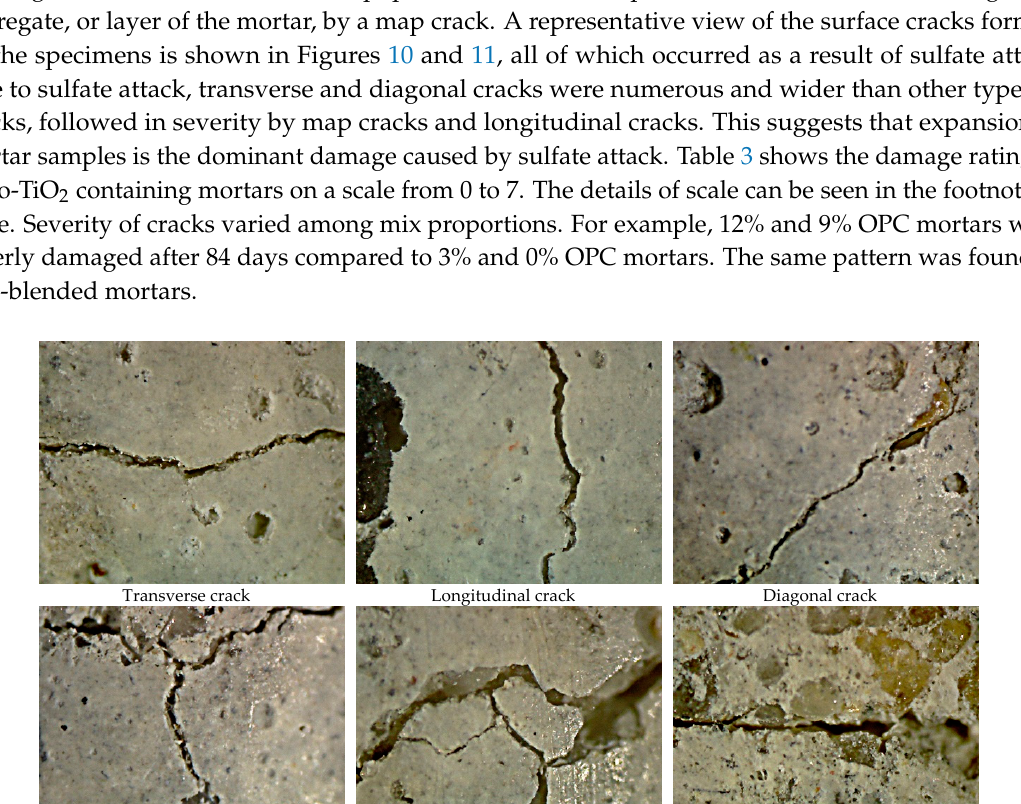
Figure 9. Variation in microhardness along depth in ( a ) nano-TiO 2 containing OPC mortars and ( b ) nano-TiO 2 containing slag-blended mortars immersed in 10% Na 2 SO 4 solution at 25 °C.